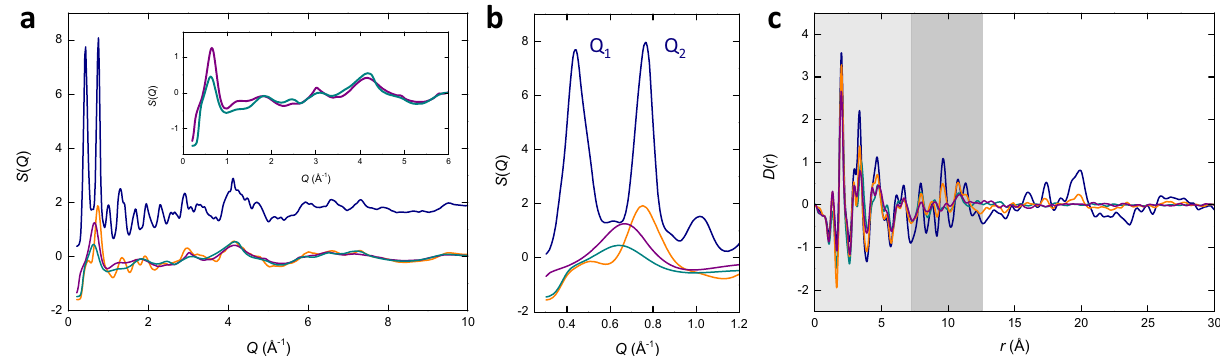
Fig. 3 Reciprocal and real space structure. a X-ray total scattering for MIL-100 (navy), Fe-BTC (orange), a m MIL-100 (turquoise) and a m Fe-BTC (purple). MIL-100 offset for clarity. Inset highlights a m MIL-100 and a m Fe-BTC. b Comparison of the low- Q structure factor data. c X-ray pair distribution functions for MIL-100 (navy), Fe-BTC (orange), a m MIL-100 (turquoise) and a m Fe-BTC (purple). The light grey region highlights peaks largely originating from the trimer unit and dark grey those from the tetrahedral assemblies. Data for MIL-100, Fe-BTC and a m MIL-100 from Refs. 13,35